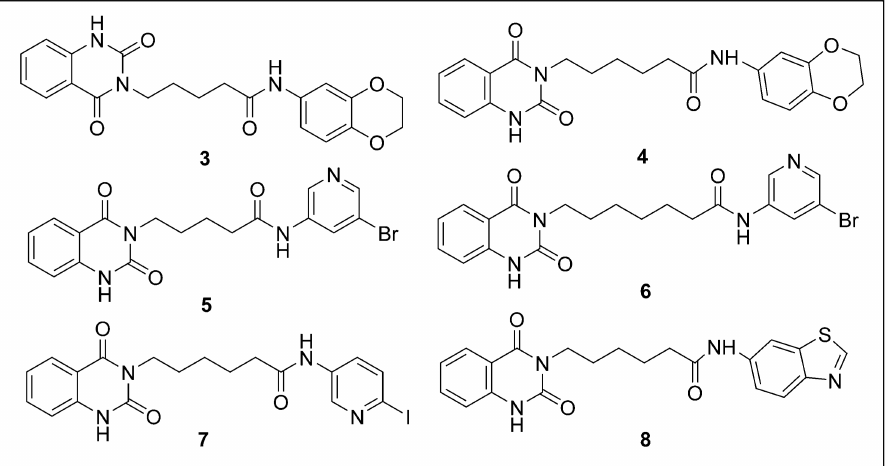
Figure 4. Chemical structures of compounds 3 – 8 selected by virtual